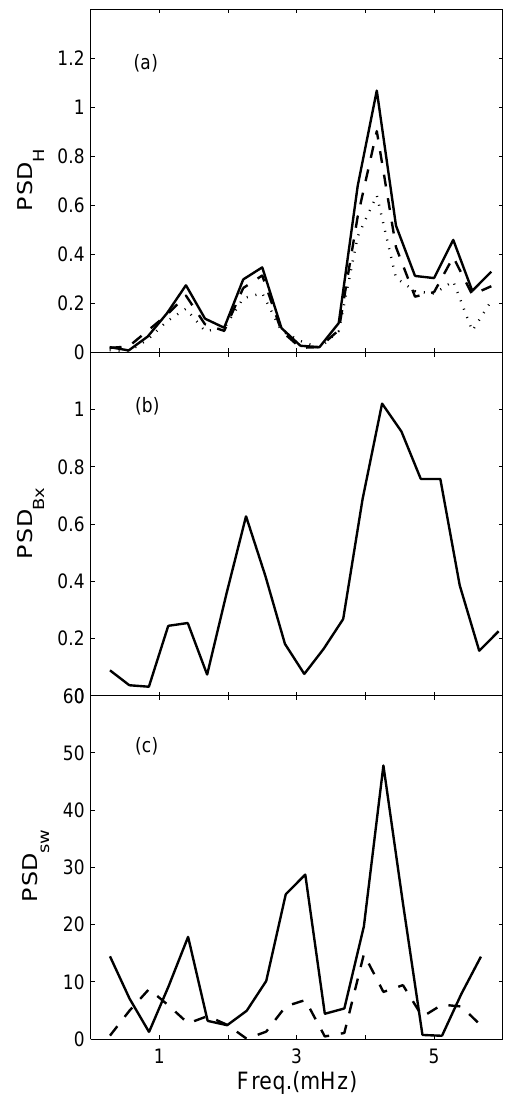
Fig. 4. (a) Power spectral density of the H component at NCK (solid line), CST (dashed line) and RNC (dotted line) in the time interval 14:18–15:18 UT on 3 April 2004; (b) power spectral density of the IMF B x component time shifted by –1h; (c) power spectral density of the SW speed (solid line) and density (dashed line) time shifted by −